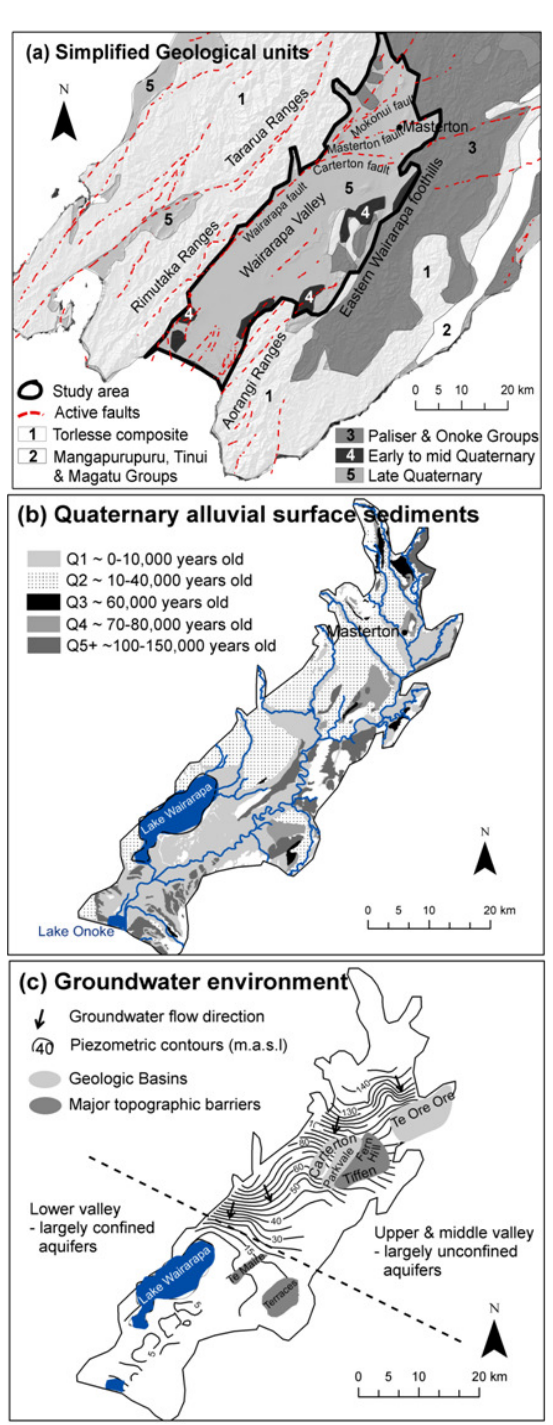
Fig. 2. Catchment characteristics of the Wairarapa Valley, New Zealand; (a) simplified regional geology, (b) quaternary (Q) alluvial surface sediment units (c) groundwater flow direction and potentio- Figure 2. Catchment characteristics of the Wairarapa Valley, New Zealand; (a) Simplified 3 metric surface map. Only major fault lines in the Wairarapa Valley Figure 2. Catchment characteristics of the Wairarapa Valley, New Zealand; (a) Simplified 3 Figure 2. Catchment characteristics of the Wairarapa Valley, New Zealand; (a) Simplified 3 are named in Fig. regional geology, (b) Quaternary (Q) alluvial surface sediment units (c) Groundwater flow 4 regional geology, (b) Quaternary (Q) alluvial surface sediment units (c) Groundwater flow 4 regional geology, (b) Quaternary (Q) alluvial surface sediment units (c) Groundwater flow 4 direction and potentiometric surface map. Only major fault lines in the Wairarapa Valley are 5 direction and potentiometric surface map. Only major fault lines in the Wairarapa Valley are 5 direction and potentiometric surface map. Only major fault lines in the Wairarapa Valley are 5 named in Figure 2a. 6 named in Figure 2a. 6 named in Figure 2a. 6